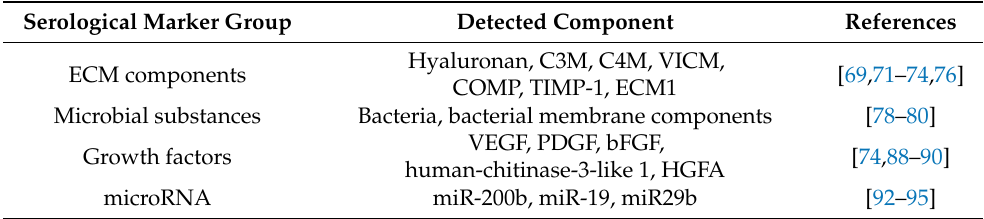
Table 3. Serological marker to discriminate intestinal inflammation from healthy